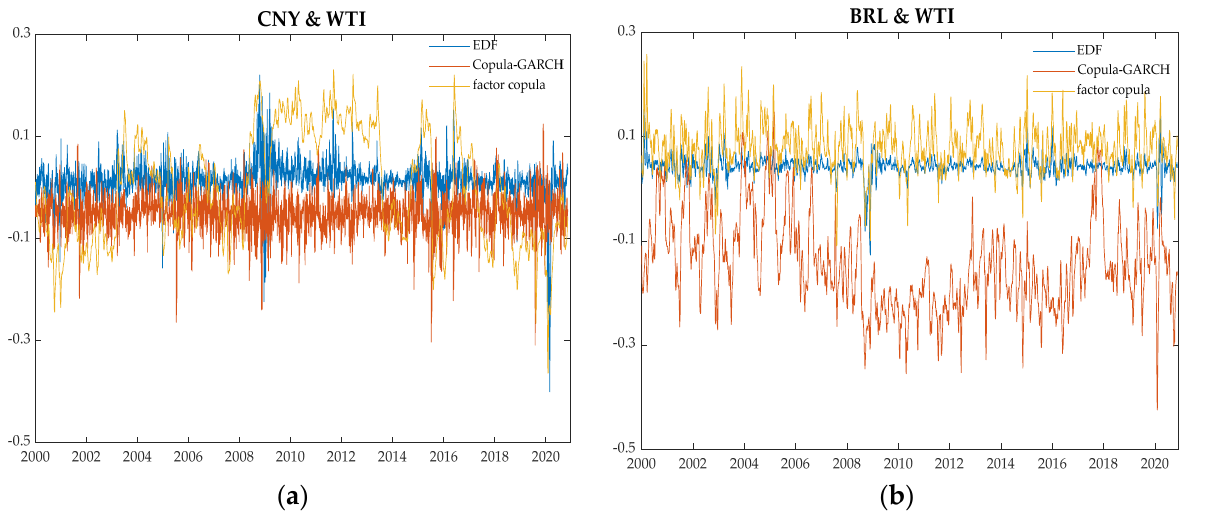
Figure 3. Dynamic Kendall coefficients of three models for typical countries. ( a ) CNY-WTI. ( b ) BRL- WTI. Note: the vertical coordinates correspond to dynamic Kendall coefficients for the respective time-varying dependence between crude oil and exchange rate markets.